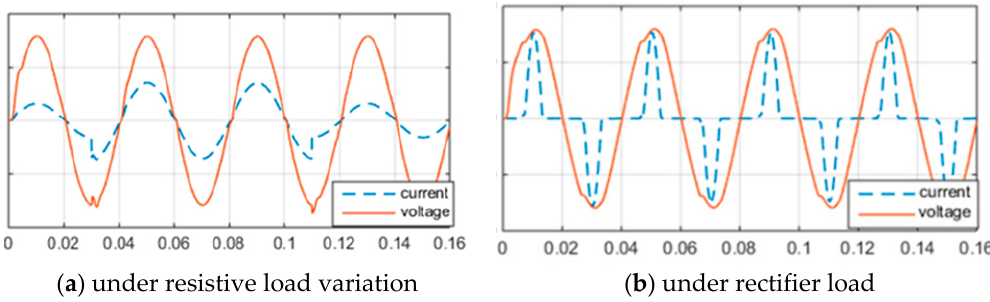
Figure 8. Simulation waveform output voltage and current.